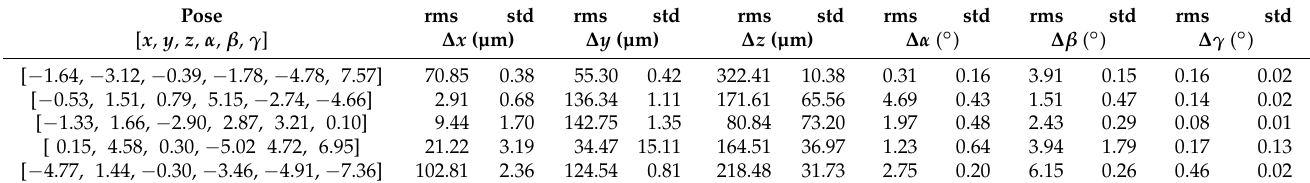
Table 2. Investigated static poses in the workspace of the hexapod and the corresponding root mean squares (rms) and standard deviations (std) of the position and orientation errors ∆ for every